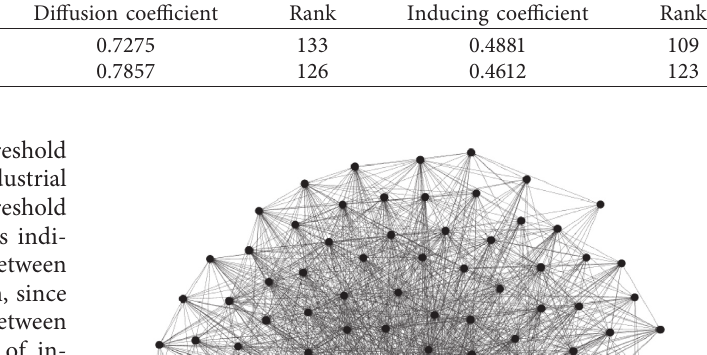
Table 4: Statistics of diffusion coefficient and inducing coefficient of the Chinese entertainment industry. Industry sector